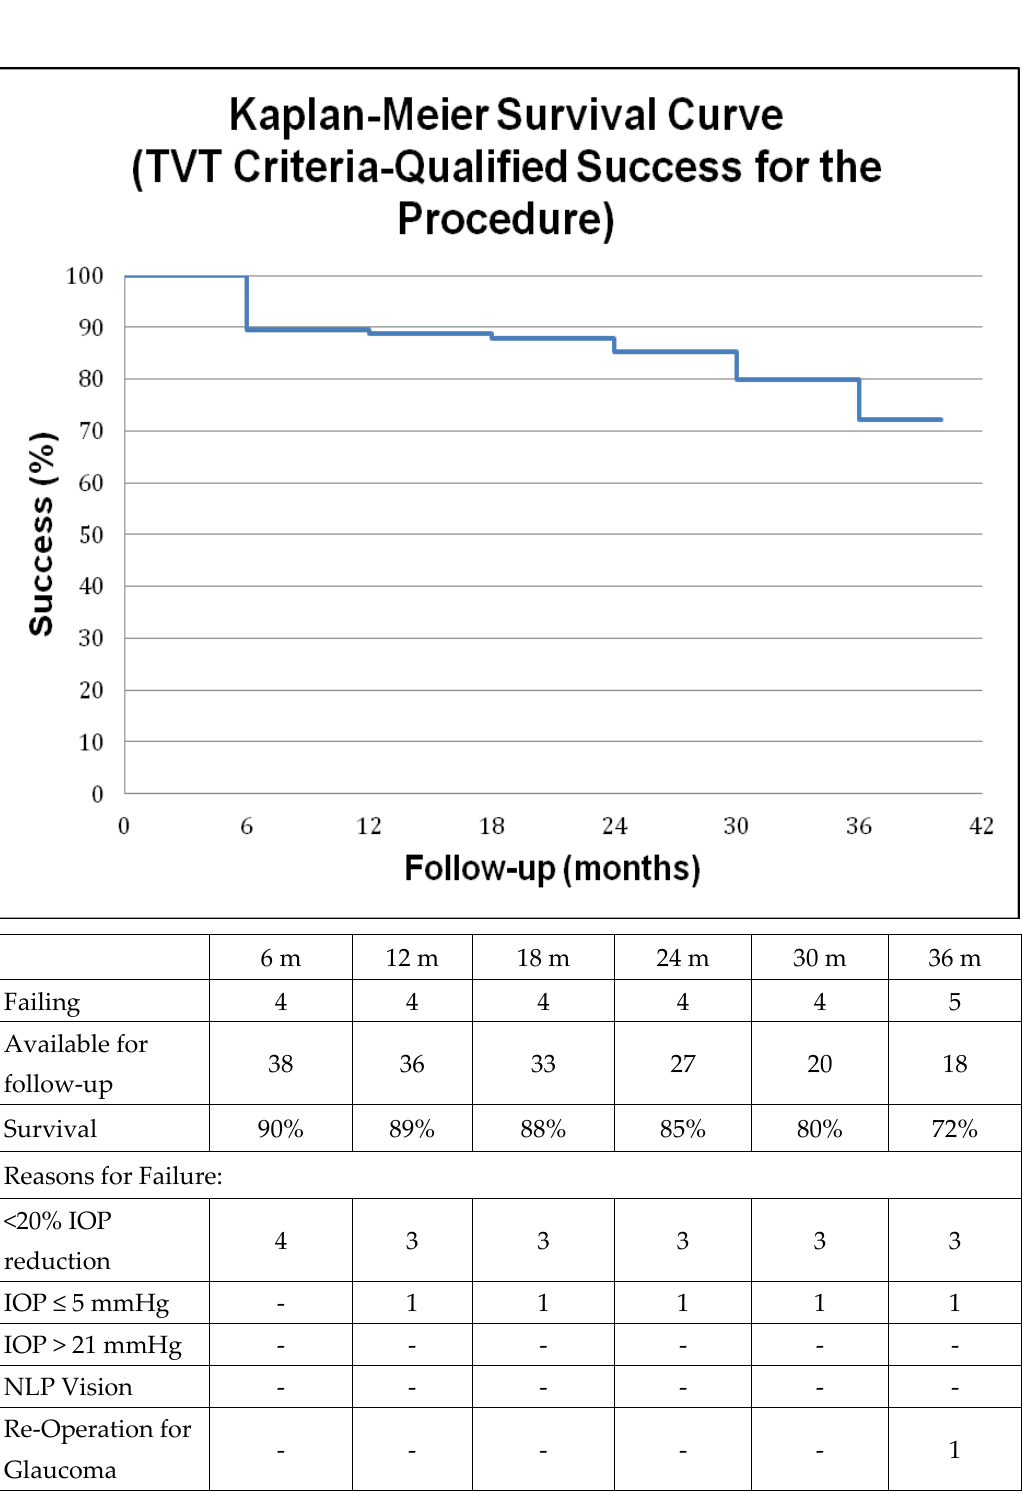
Figure 3. Kaplan – Meier survival curve with or without medications (qualified success) for the surgical procedure according to the Tube versus Trabeculectomy Study (briefly, failure was defined as intraocular pressure (IOP) > 21 mmHg or <6 mmHg on two consecutive visits, or IOP not reduced by at least 20%, or loss of light perception or re-operation for glaucoma).